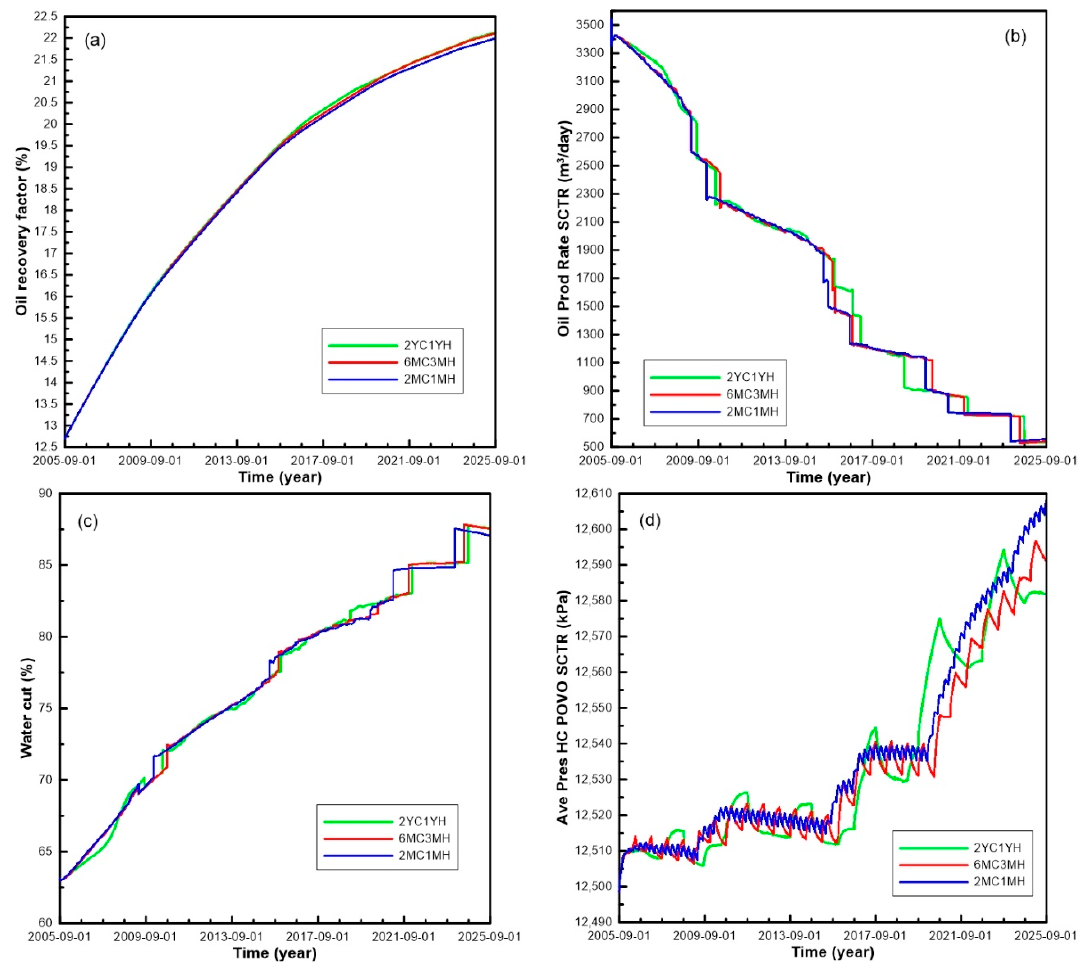
Figure 9. Simulated curves of oil recovery factor ( a ), oil production rate ( b ), water cut ( c ) and average reservoir pressure ( d ) of during the CO 2 flooding with a WAG ratio of 2:1.